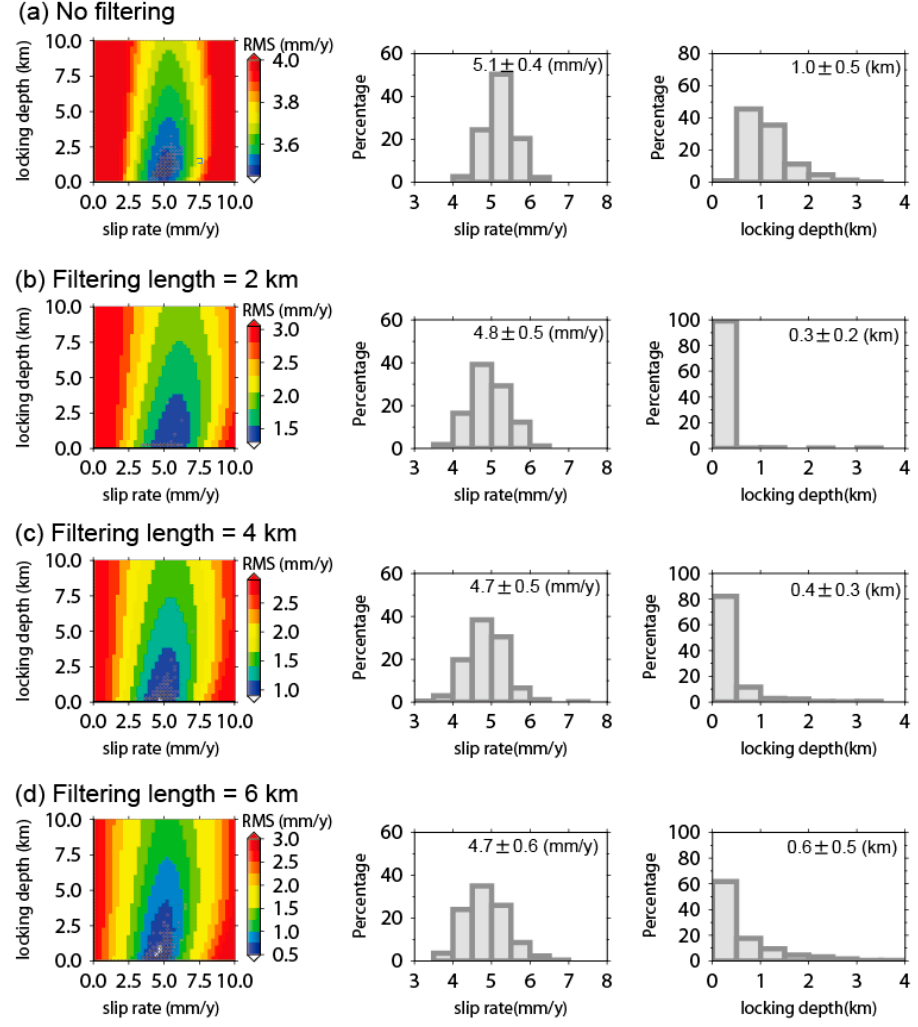
Figure 8. Inversion results: the first column shows the slip rate versus fault locking depth; the second and third columns reveal the statistic distribution of the slip rate and locking depth inferred from each velocity profile. In the first column, the black circles represent the optimal solution inferred from 500 Monte Carlo simulations. ( a ) Shows the result that was inferred from the original data; ( b – d ) show the results that were inverted from filtered data with filtering length of 2 km, 4 km and 6 km respectively.